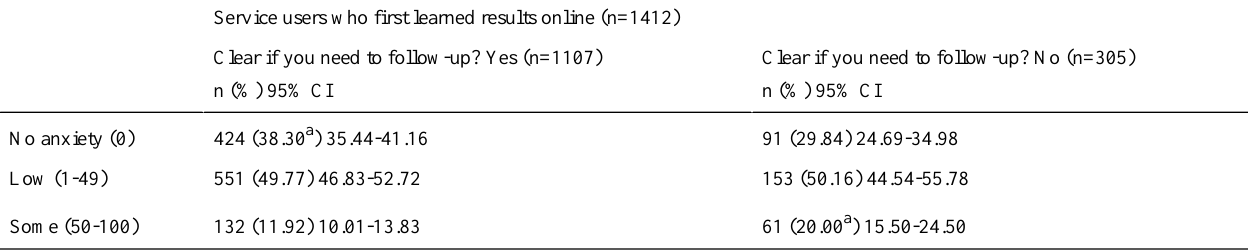
Table 6. Anxiety level after receiving lab test results according to comprehension. Service users who first learned results online (n=1412)